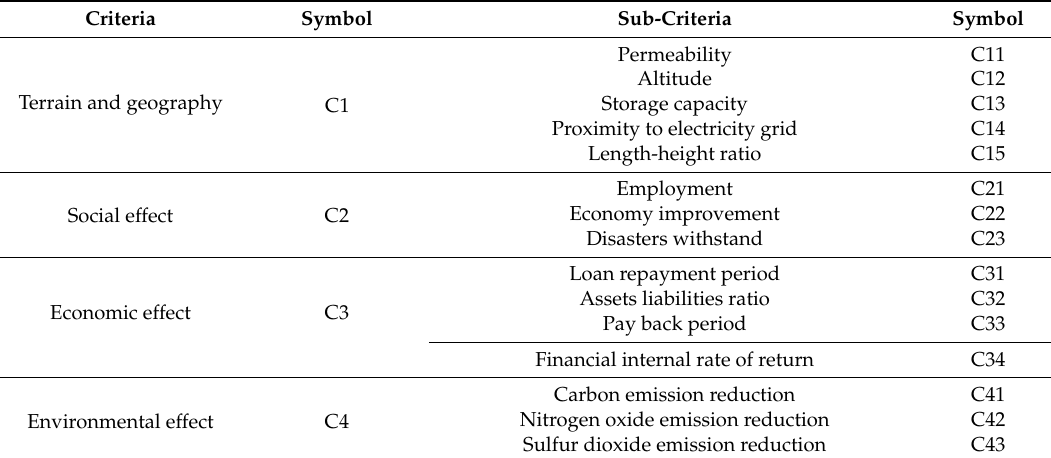
Table 1. The criteria and sub-criteria of PHESP site